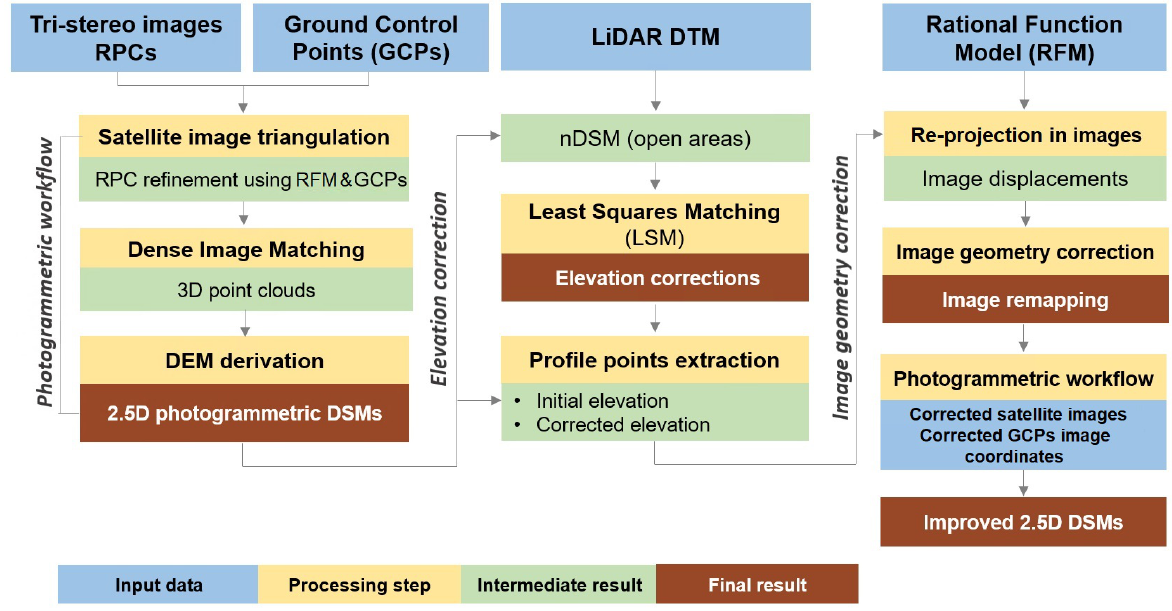
Figure 1. Processing workflow for satellite image geometry correction